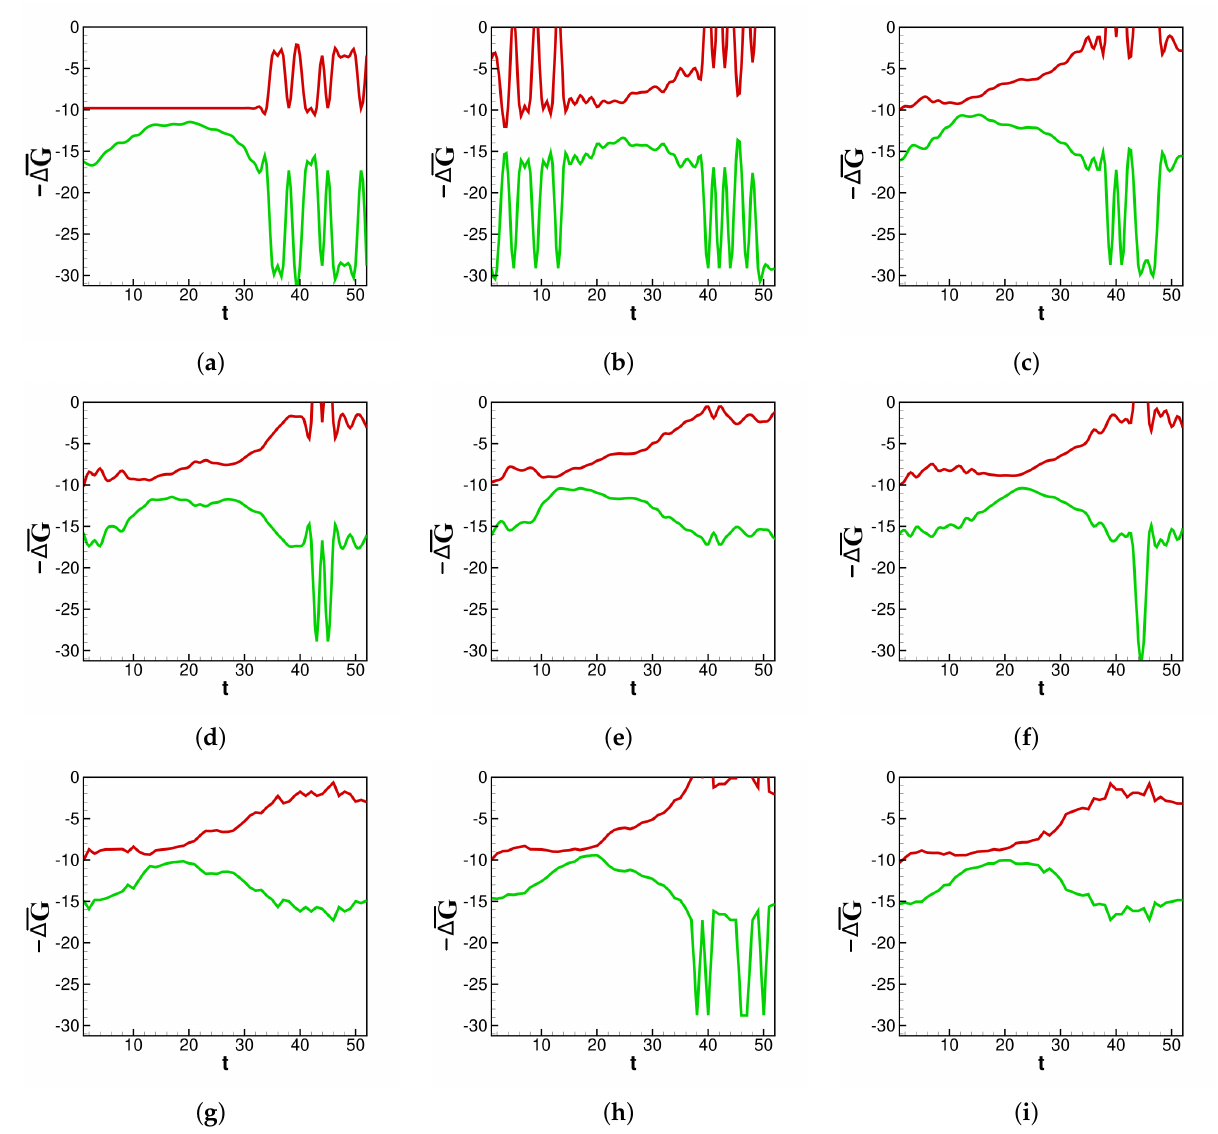
Figure 2. In ( a − i ) The green line represents ¯ ∆ G I and the red line is ¯ ∆ G D . Flu season